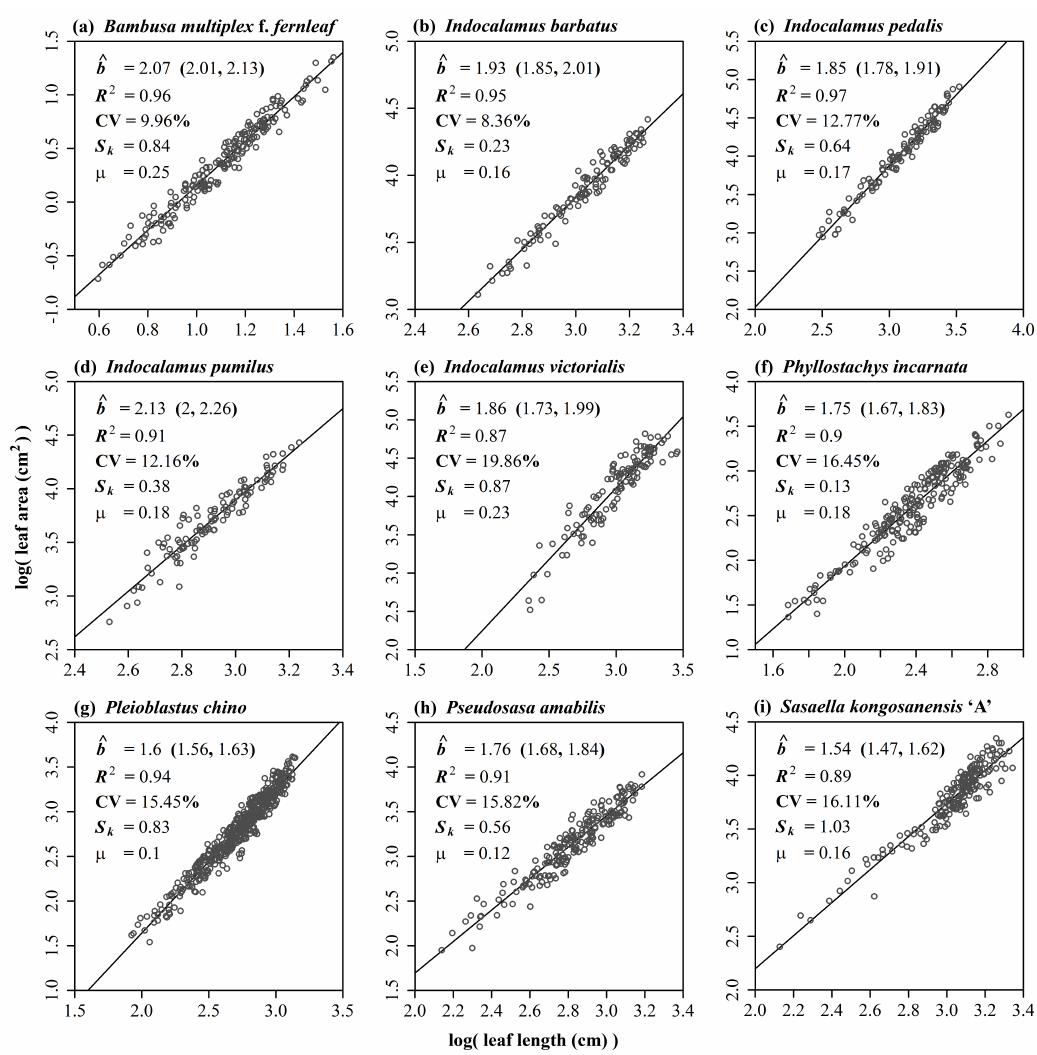
Figure 8. Scaling relationship between leaf area and leaf length. ( a ) Bambusa multiplex f. fernleaf (R. A. Young) T. P. Yi; ( b ) Indocalamus barbatus McClure; ( c ) Indocalamus pedalis (Keng) P. C. Keng; ( d ) Indocalamus pumilus Q. H. Dai and C. F. Keng; ( e ) Indocalamus victorialis P. C. Keng; ( f ) Phyllostachys incarnata T. H. Wen; ( g ) Pleioblastus chino (Franchet & Savatier) Makino; ( h ) Pseudosasa amabilis (McClure) Keng f.; ( i ) Sasaella kongosanensis ‘Aureostriatus’ (Nakai) Nakai ex Koidz. The open circles represent observations, and the solid line represents the regression line between leaf area and leaf length. Here, ˆ b represents the estimate of slope (i.e., the scaling exponent between leaf area and leaf length); R 2 represents the coefficient of determination to reflect the goodness of fit; CV is the coefficient of variation of the ratios of leaf width to leaf length; S k represents the skewness of the ratios; µ represents the mean of the